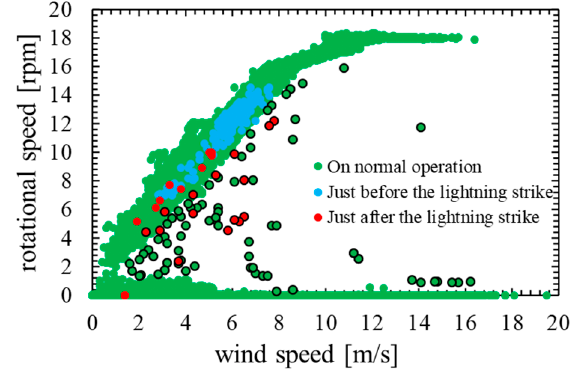
Figure 2. Wind speed rotational speed characteristic.